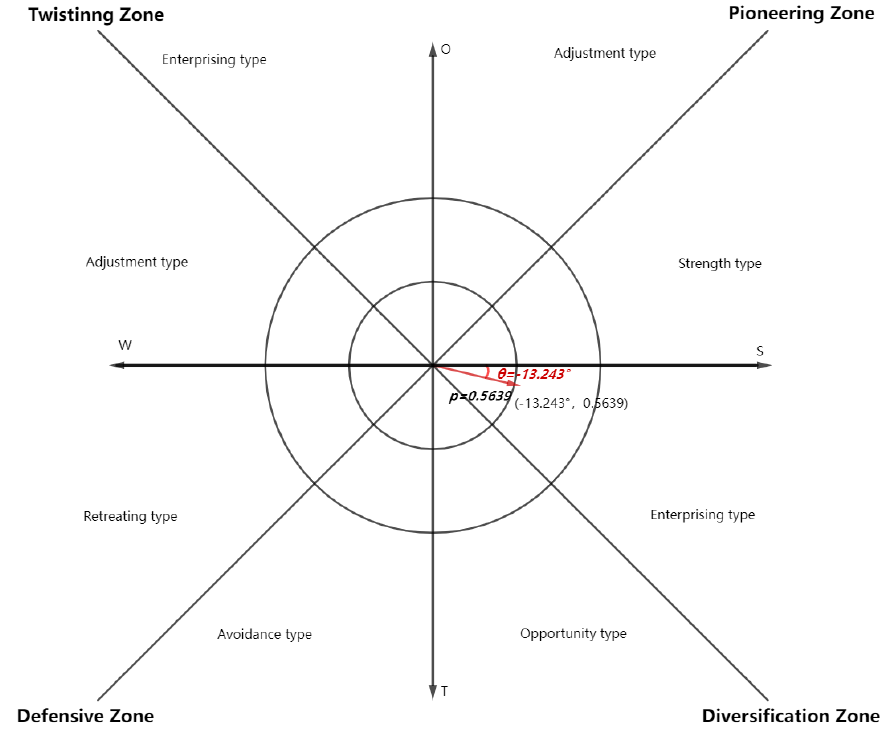
Figure 3. The SWOT strategy quadrilateral. S : Strength, W : Weakness, T : Threats and O : Opportunity. Substitute the strategic vector angles into the coordinate system, as shown in Figure 4.